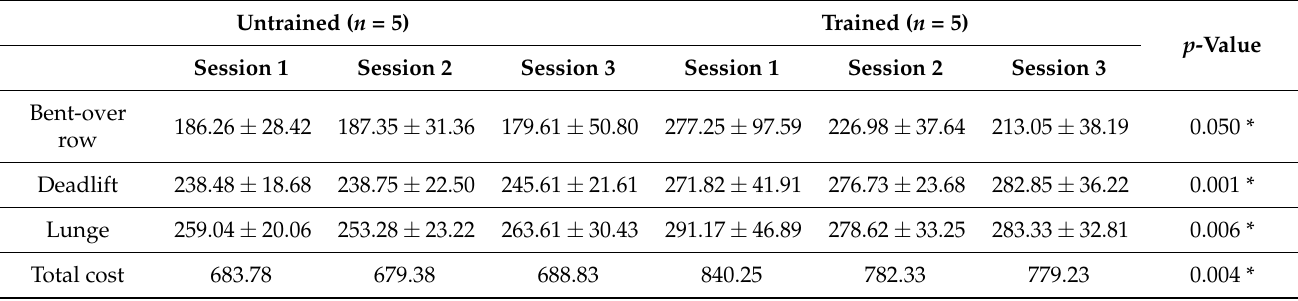
Table 3. Energy expenditure (EE) sum in kilocalories ( n =